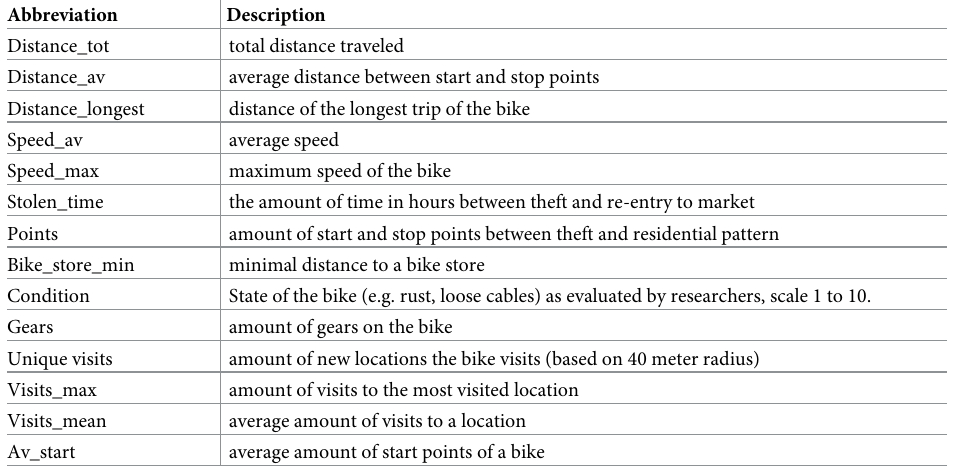
Table 1. Collected variables of the stolen bikes’ routes and